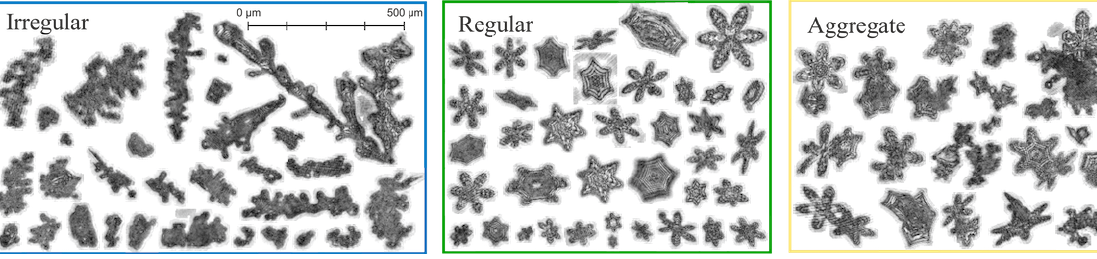
Figure 3. Examples of 2-D images taken by the holographic imager HOLIMO for the three subclassifications of ice crystal habits (irregular, regular and aggregates). The images are a collection recorded during the field campaign at different heights of the